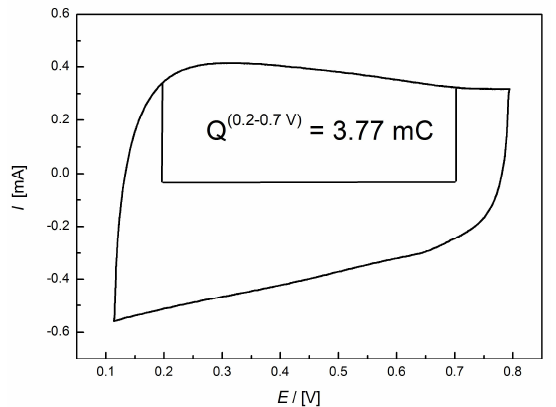
Figure 9. Cyclic voltammogram of the CA sample after ORR measurements. (Loadings: 100 µg/cm 2 , Sweep rate: 50 mV/s.).